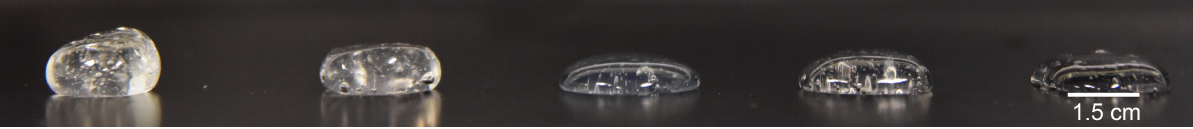
Figure 4: Aqueous polyvinyl alcohol, transiently crosslinked, displays a wide range of elastic modulus but a comparatively narrow range of relaxation timescales. From left to right, concentrations (PVA wt % :Borax wt % ) are: 3.50:1.25, 2.75:1.25, 3.50:0.10, 2.75:0.10, 2.00:0.50. (Photos taken 10 minutes after initial spherical